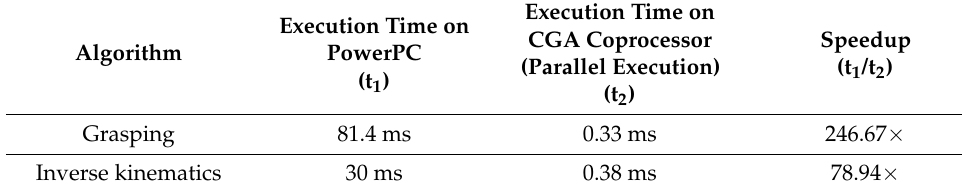
Table 11. Algorithm speedup.